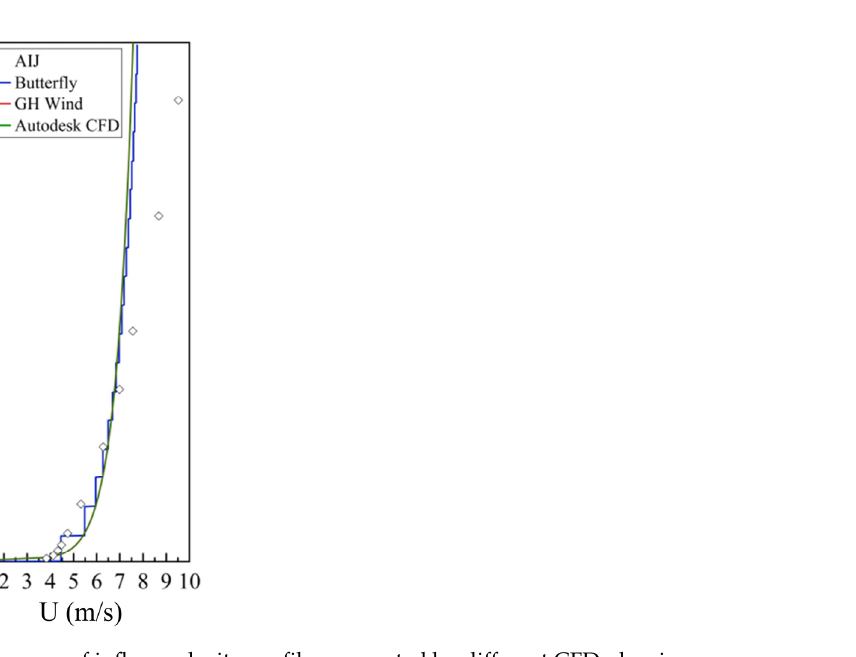
Figure 2. Diagram of inflow velocity profiles generated by different CFD plug-ins.